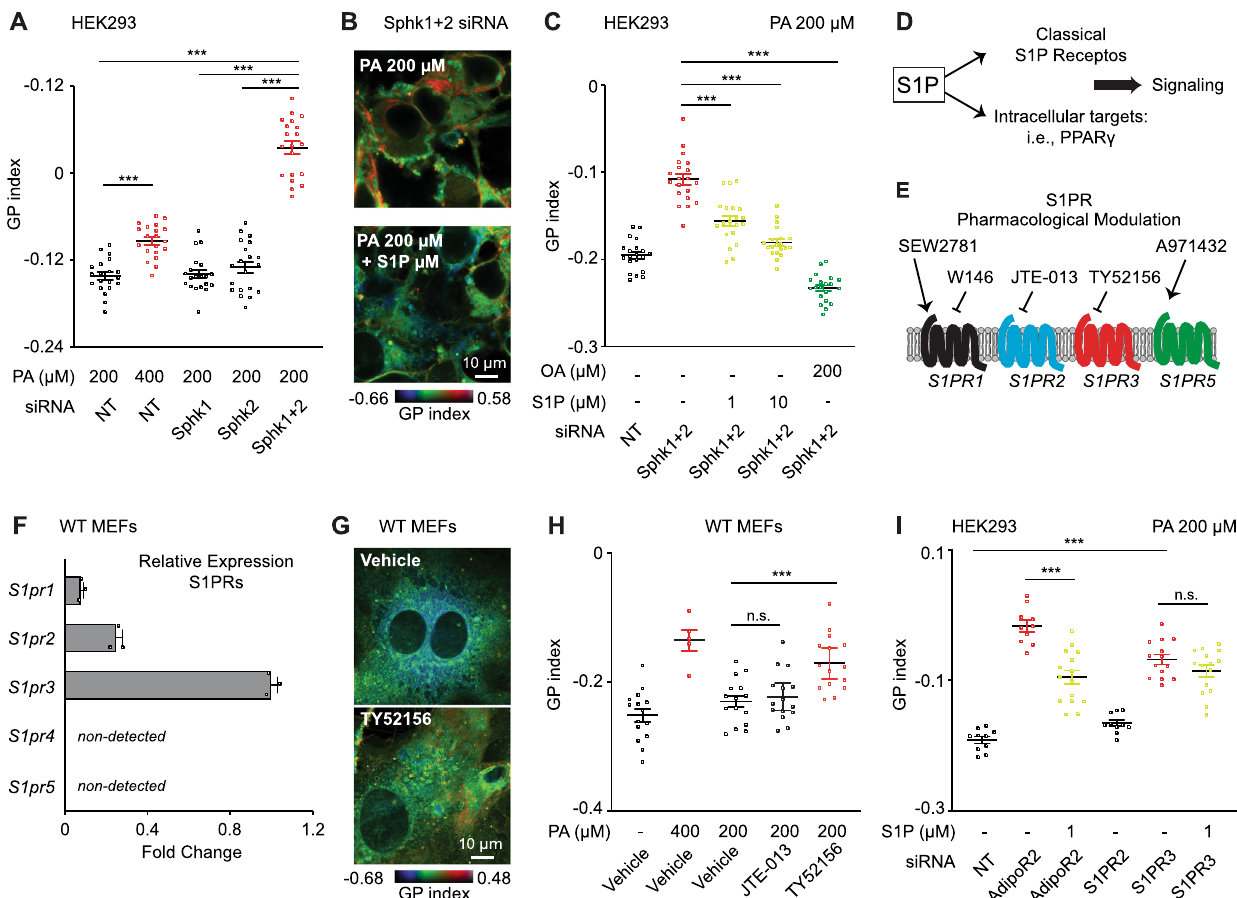
Fig. 4 | Sphingosine kinases and S1PR3 are required to maintain membrane homeostasis in human/mouse cells. A Average GP index from several images